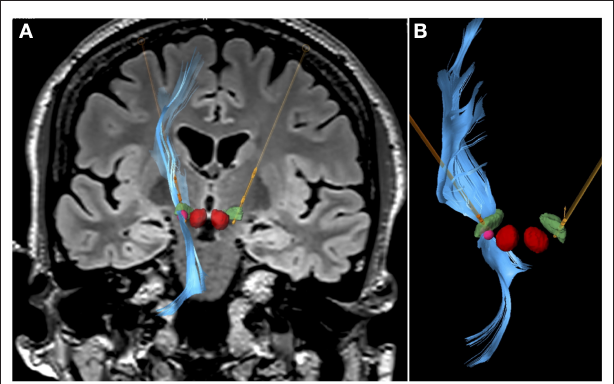
FIGURE 3 | Tractography study. Representation of the associative fibers stimulated when contact 3 in the left STN was activated at 1.5mA, 60 µ s, and 130Hz. (A) Coronal flair 3T MRI view, with segmentation of bilateral red nucleus (red), bilateral STN (green), directional leads (orange), and VTA (pink sphere) generated with contact 3 stimulation. Fibers toward the prefrontal cortex in the left side are represented in blue. (B) Close view of the left directional lead, left STN and the fibers passing through the VTA generated (in contact 3) toward the frontal region. Images obtained with Elements © software (Brainlab © ) and Guide XT © software (Boston